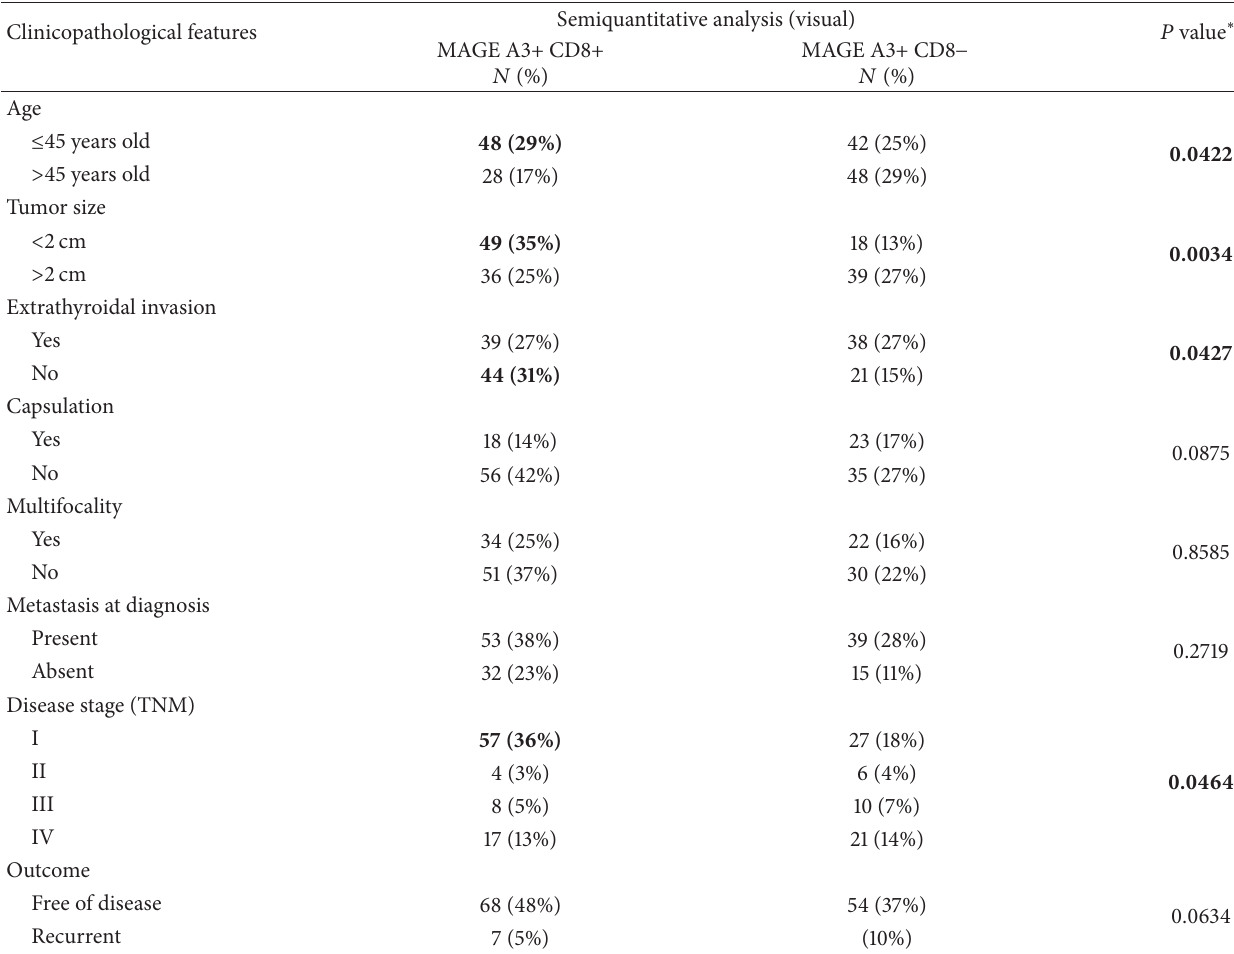
Table 3: Immunohistochemical expression of MAGE A3 and CD8 TIL, according to clinicopathological features of aggressiveness and patient’s